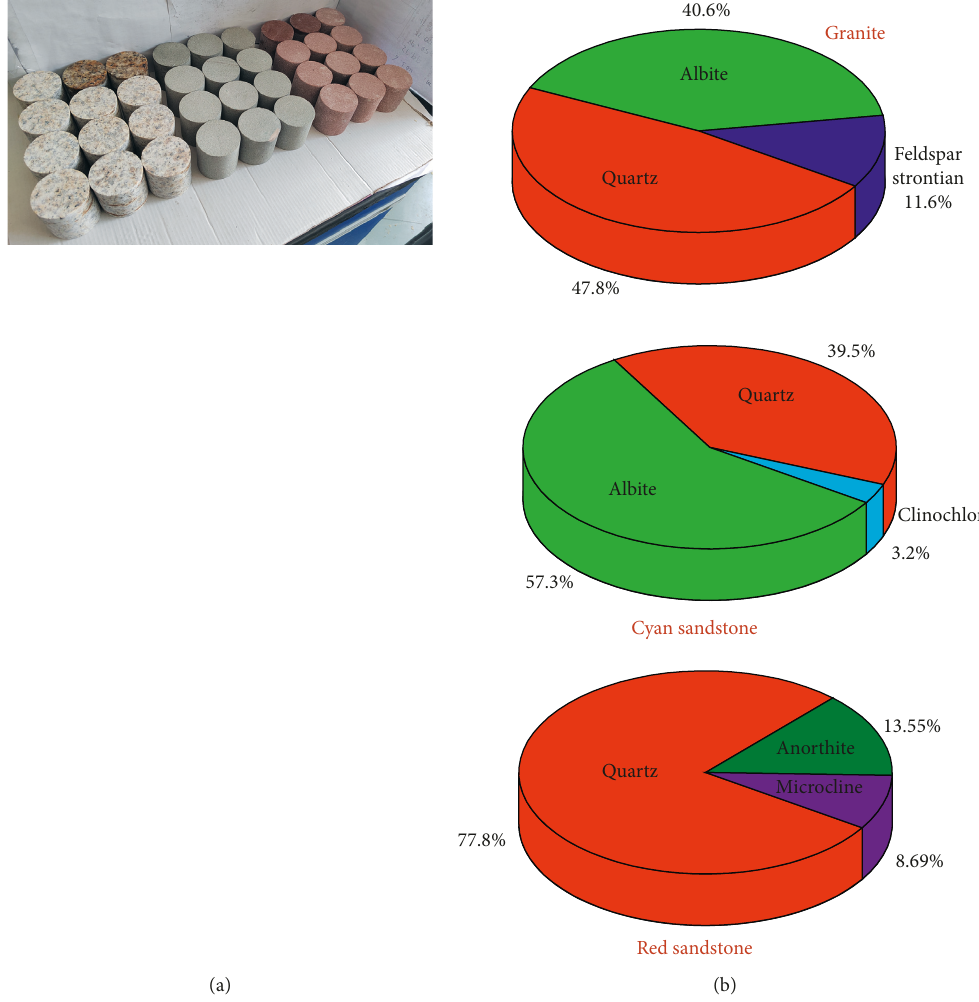
Figure 1: Photographs of (a) the test samples (granite, cyan sandstone, and red sandstone) and (b) their mineralogical composition.